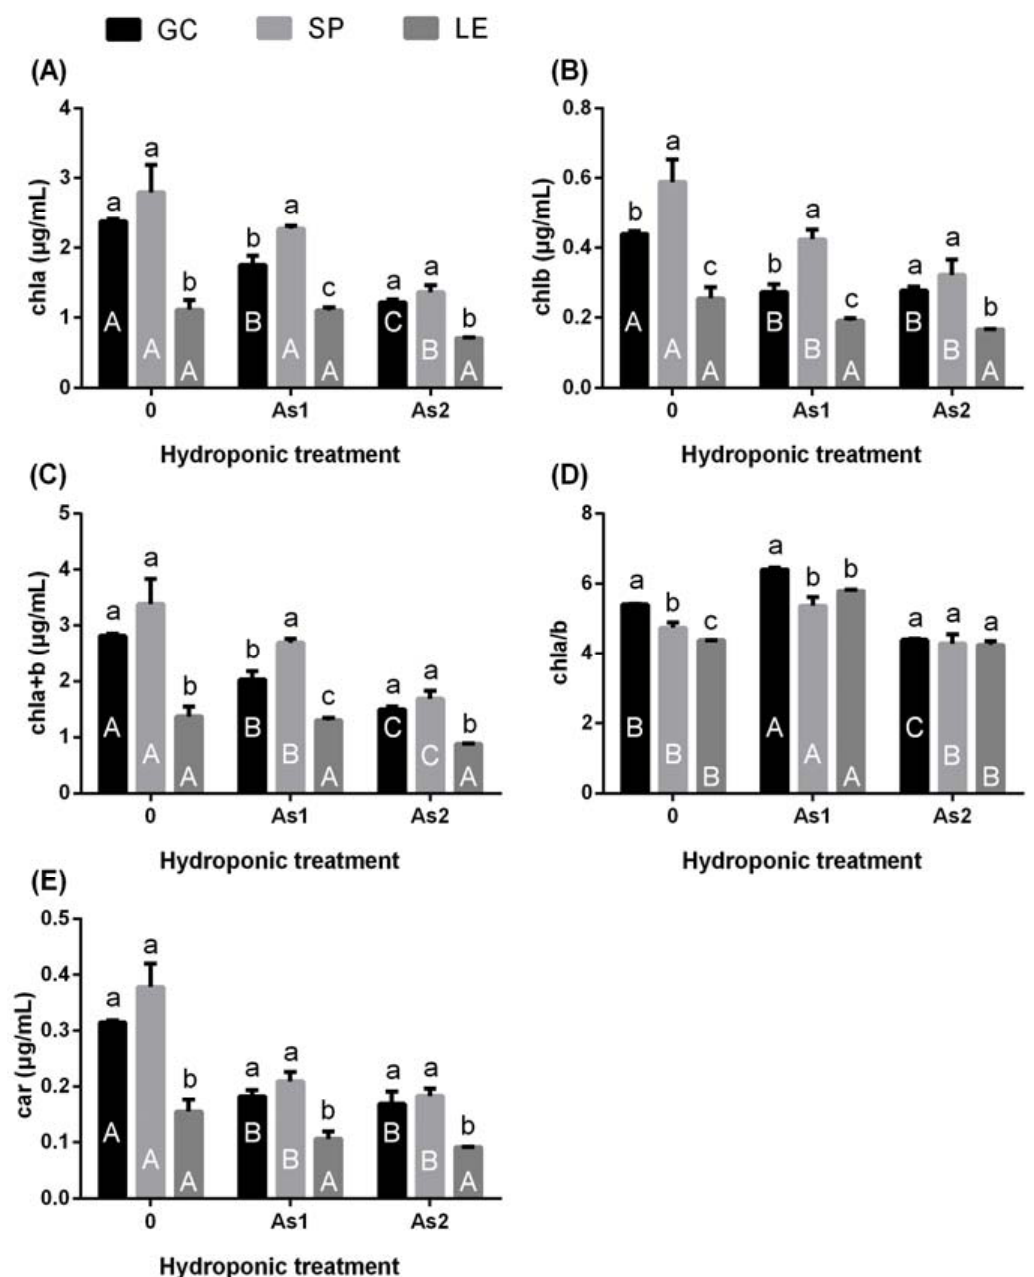
Figure 3. The content of chlorophyll (chla, chlb) ( A , B ) and carotenoids (car) ( E ) and the values of chla+b ( C ) and chla/b ( D ) of GC, SP, and LE under hydroponic As treatment. Note: Different lowercase letters in the figure indicate comparisons between different vegetables under the same treatment; different uppercase letters indicate the comparison of the same vegetable under different treatments (5% levels). The error bars in the graph indicate the SEM (standard error of the mean).